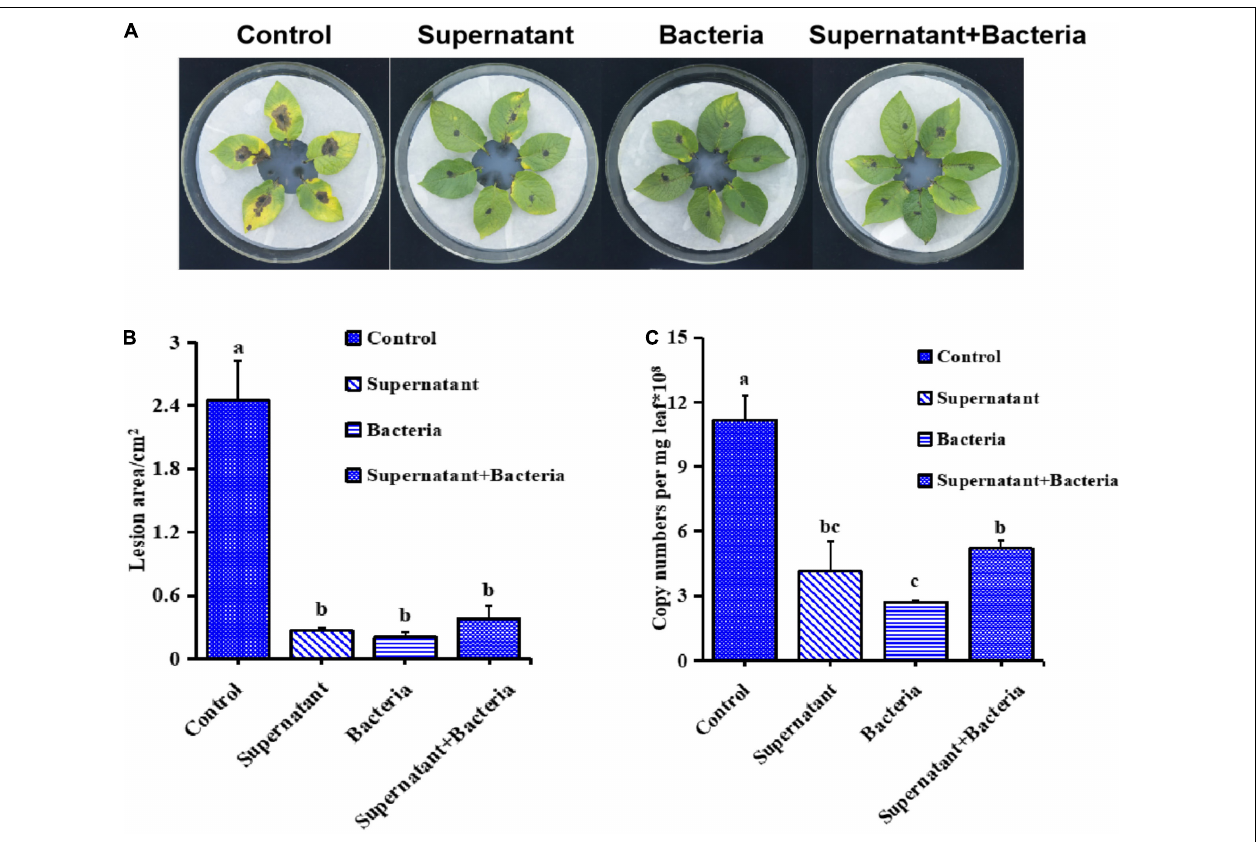
FIGURE 2 | Bacillus subtilis ZD01 significantly reduced the disease severity caused by A. solani HWC-168 on potato leaves in vivo . (A) Evidence of disease development on potato leaves treated with the ZD01supernatant, bacteria and fermentation broth prior to A. solani HWC-168 inoculation. (B) The lesion areas of potato leaves of potato inoculated with A. solani HWC-168 and co-cultured with ZD01 supernatant, bacteria and fermentation broth. (C) Quantitative detection by qPCR of A. solani HWC-168 growth on potato leaves inoculated with A. solani HWC-168 and co-cultured with the ZD01 supernatant, bacteria and fermentation broth. Data are presented as means of three replicates ± SDs, and error bars represent the SDs for three replicates. Means with different letters are significantly different ( p <